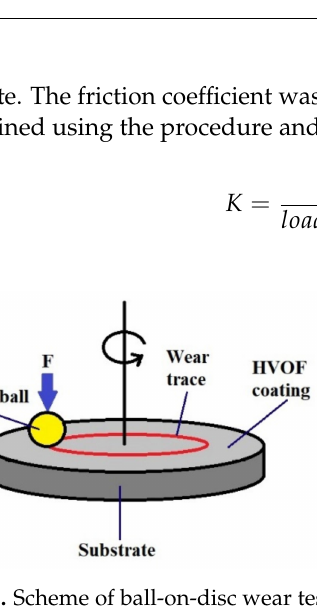
Figure 1. Scheme of ball-on-disc wear testing.